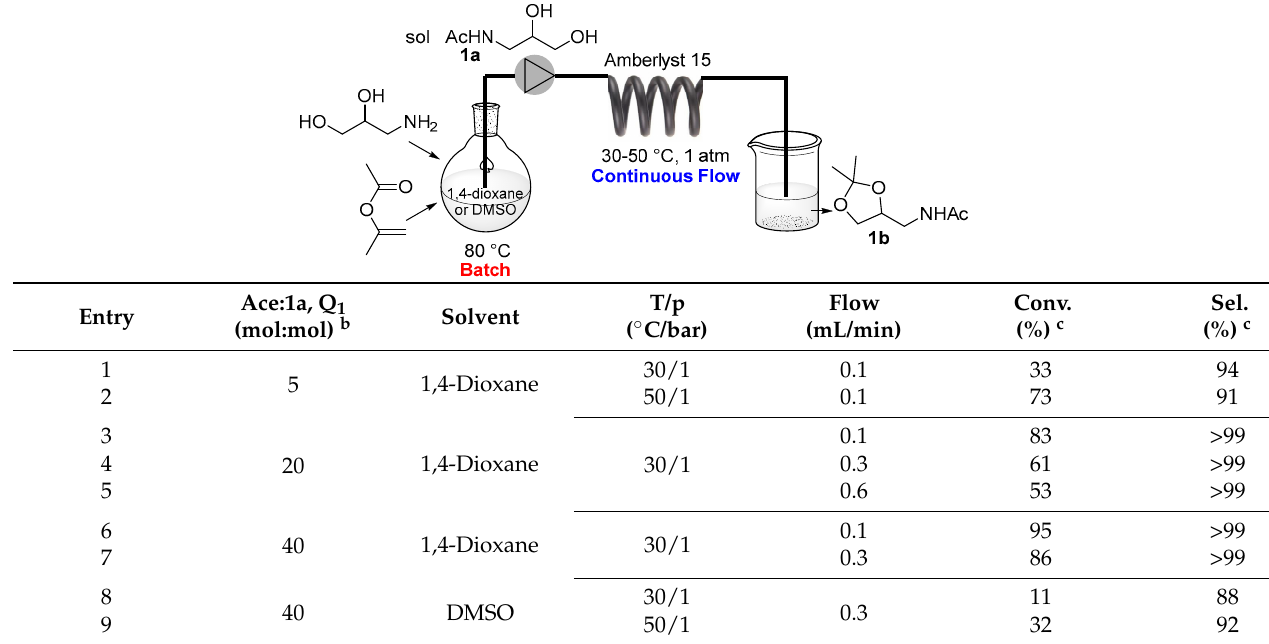
Table 3. The concatenated sequence: CF-acetalization of crude amide 1a in the presence of dioxane or DMSO solvent a .